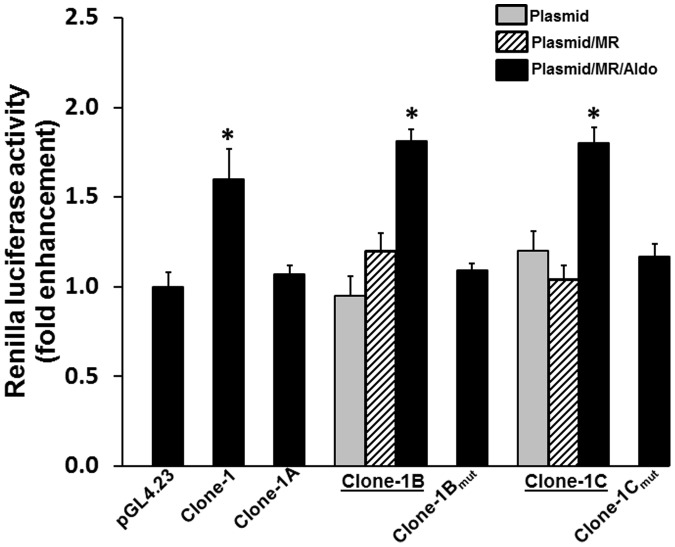
Sub-localization of mineralocorticoid hormone responsive element (MRE) in clone 1.Sub-clones of clone-1 were made and tested for MR/aldosterone responsiveness in HEK 293T cells. Clone-1 was sub-cloned into thirds, clone-1A, clone-1B and clone-1C representing the left, middle and right thirds, respectively. Clone-1B and clone-1C exhibited enhanced luciferase activity. Putative MREs were identified in clone-1B and clone-1C using TESS and MatInspector bioinformatics tools. The sequence TCTTGA
GTGTGTTCT
 in clone-1B (candidate MRE underlined) was mutated to TCTTGcGTGcacgac (clone-1Bmut) (see Figure S1 for sequence). The candidate MRE GGCTCT
GCGTGTTCT
 in clone-1C was mutated to GGCTgTGCGcacgac (clone-1Cmut). The absence of the enhanced luciferase activity in the HEK293T cells transfected with clone-1Bmut and clone-1Cmut showed a loss of function, thus demonstrating functionality of the MREs localized in clone-1B and clone-1C. Data presented represent mean ± SE of triplicate assays from 3 different experiments. *p<0.05– compared to pGL4.23.